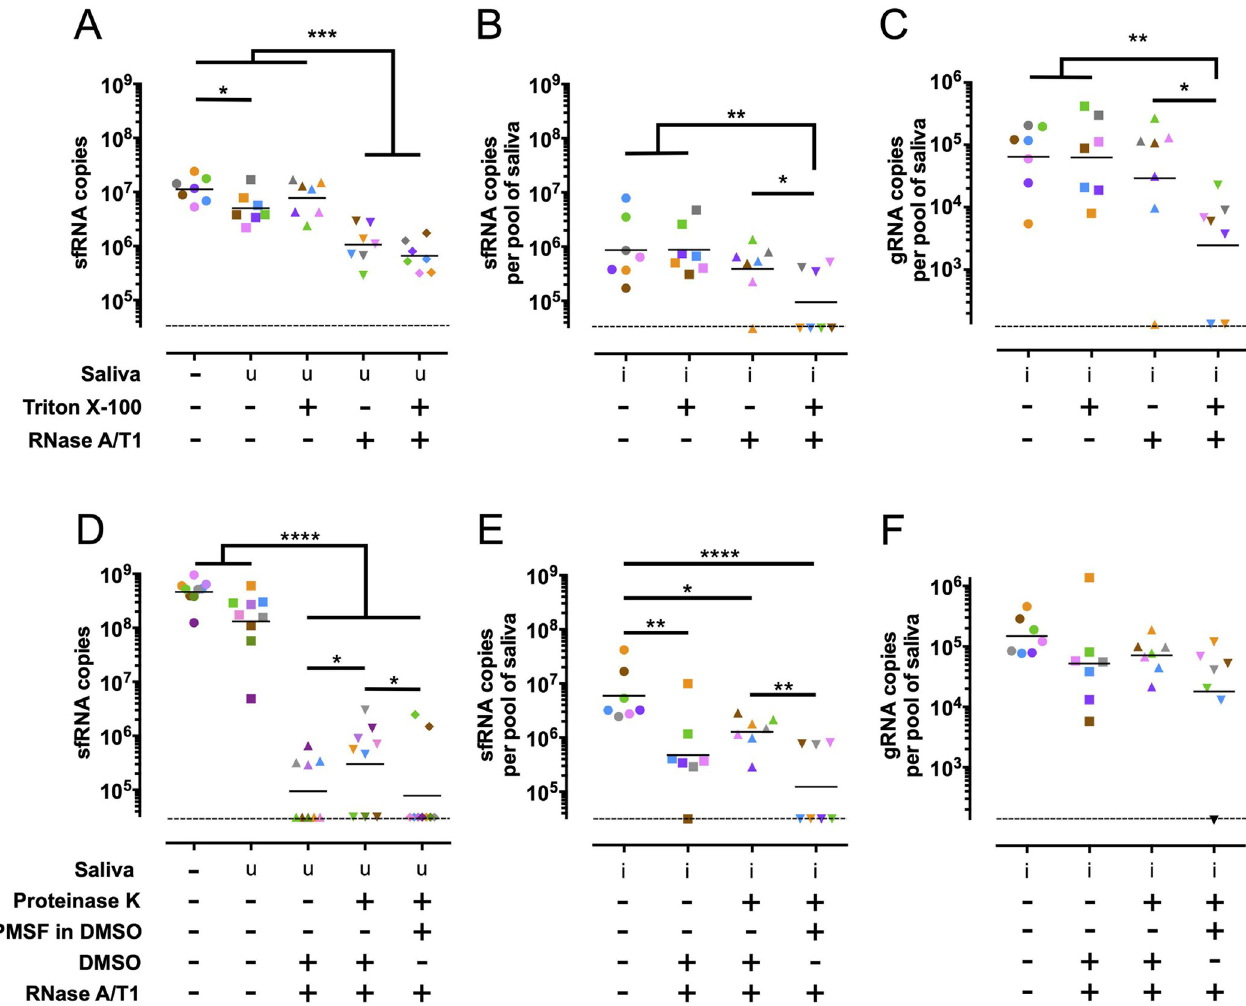
Fig 2. Salivary sfRNA is sensitive to nuclease degradation only after detergent treatment. ( A - C ) Impact of Triton X-100 treatment on nuclease resistance for in vitro transcribed sfRNA1 in uninfected saliva ( A ) and for sfRNA1 ( B ) and gRNA ( C ) from infected saliva. ( D - F )Impact of DMSO and Proteinase K treatment on nuclease resistance for in vitro transcribed sfRNA1 in uninfected saliva ( D ) and for sfRNA1 ( E ) and gRNA ( F ) from infected saliva. Compare the third and fourth group in E to note that unless inhibited by PMSF PK decreased RNase activity. Symbol colors indicate biological repeats. Saliva samples were collected from three mosquito batches. Dashed lines indicate limits of detection which were 133 copies in gRNA and 31,216 copies in 3’ UTR/ sfRNA1. u, uninfected. i, infected. � , p-value < 0.05; �� , p-value < 0.01; ��� , p-value < 0.001, ���� , p-value < 0.0001 as determined by Fisher’s LSD test.